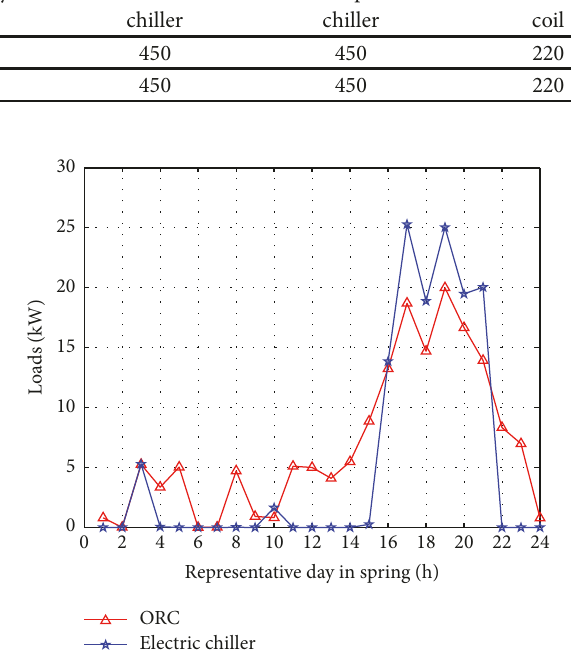
Figure 11: Hourly outputs of the EC and ORC in a spring day.